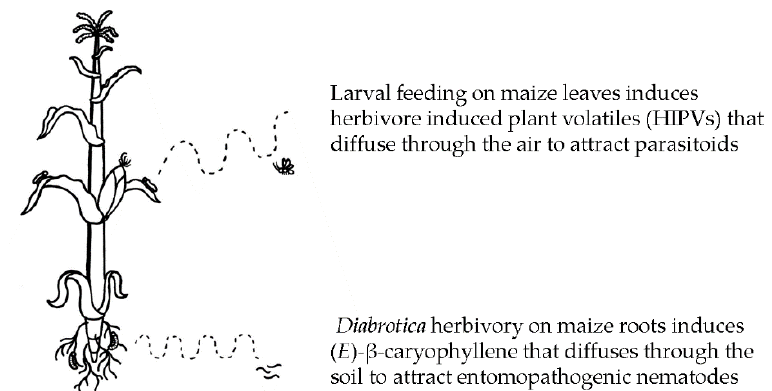
Figure 3. Volatile compounds in maize are induced in response to above or below-ground herbivory and act as an indirect defense mechanism via the attraction of predatory or parasitic organisms that help control the attacking pest.